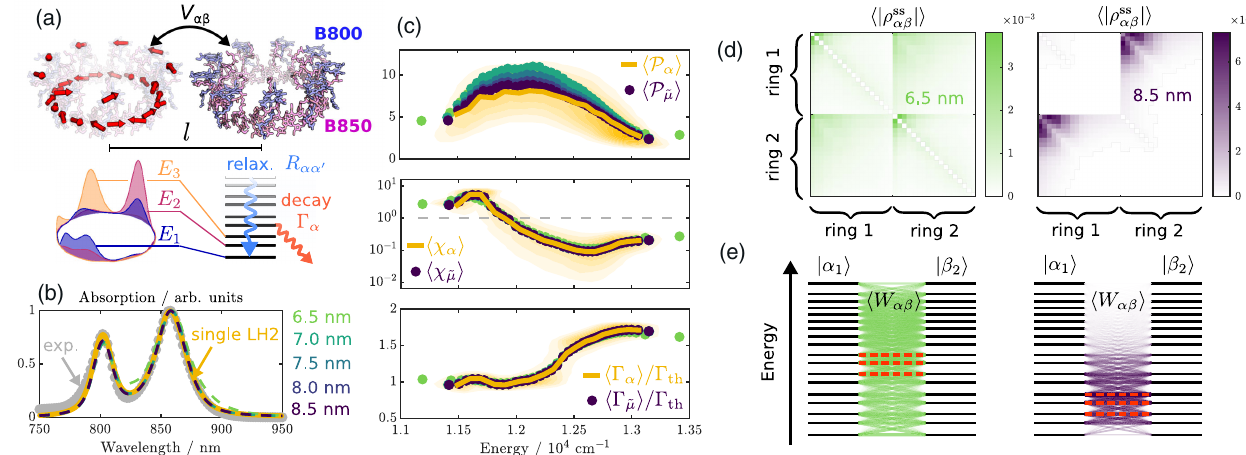
FIG. 2. Excitons in bacterial light-harvesting units. (a) Pigment arrangement in a LH2 antenna from Rps. acidophila [49]. B850 (violet) and B800 (blue) rings are composed, respectively, of 18 and 9 BChls, whose Q transition dipoles are indicated by red arrows. y Electronic excitations are partially delocalized and undergo relaxation within the exciton manifold; they decay to the ground state or transfer to neighboring rings. (b) Experimental absorption spectrum [55] (gray dots) and theoretical fit of the B800 and B850 bands of LH2. The inclusion of coherent inter-ring couplings in an LH2 pair (green to violet dashed lines) only leads to small deviations from the single-ring absorption (yellow line). (c) Energy distribution of the participation ratio (top), brightness (center), and decay rates (bottom) of B850 excitons, for a single ring (yellow line) and for a coherently coupled B850 pair for different inter-ring distances (green to violet dots). For a single ring, the underlying distribution is shown (yellow shading). Most delocalized states lie in the midenergy range; superradiant excitons ( χ α > 1 , above the gray dashed line) occupy the low-energy end of the spectrum, whereas the states with stronger dissipation are high-energy dark states. Two-ring excitons are slightly more delocalized, but all two-ring quantities lie within the single- ring distributions. (d) Steady-state density matrix of two coherently coupled B850 rings undergoing local relaxation and dephasing in the single-ring exciton basis, for l ¼ 6 . 5 nm (green) and 8.5 nm (violet). Excitons are organized in ascending energy and grouped according to the ring to which they belong. Populations are set to zero to increase contrast. (e) Average energy-transfer rates h W αβ i between two B850 rings for l ¼ 6 . 5 nm (green) and 8.5 nm (violet). Thicker and darker lines correspond to faster transfer. The three fastest transfer pathways are highlighted (red dashed lines). For short l , the excitons in the mid-high-energy range are mostly involved in energy transfer. Averages are performed over 10 4 realizations of static